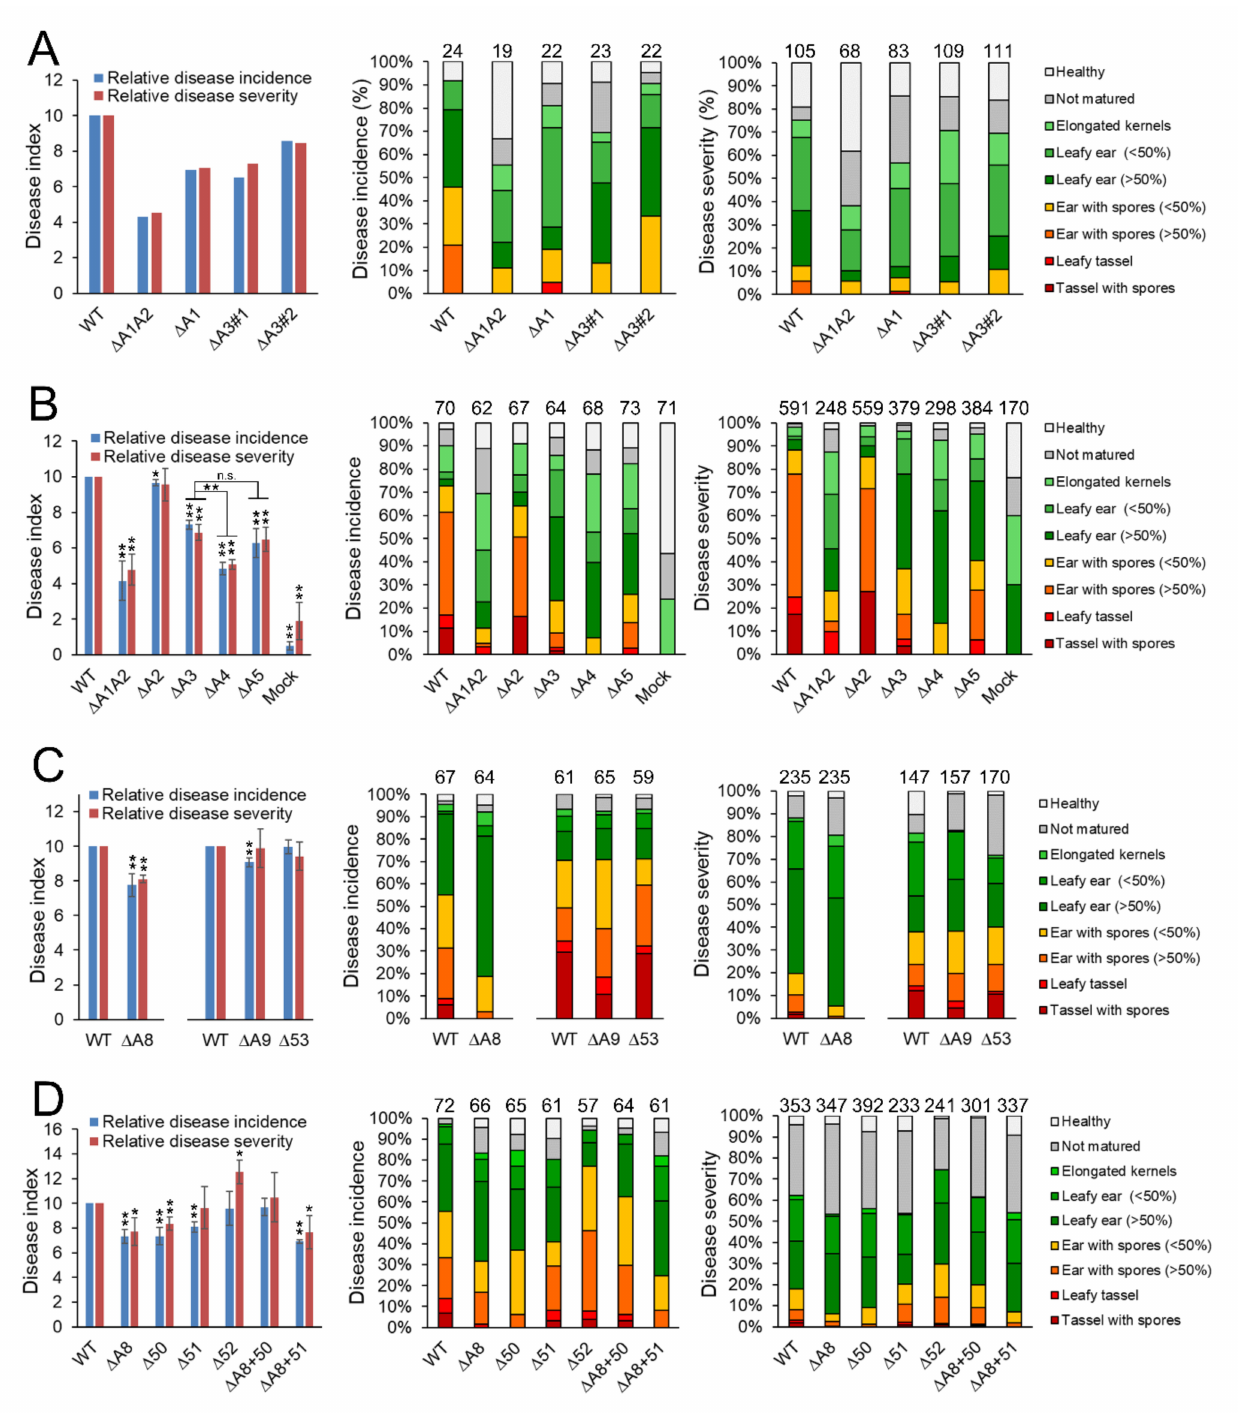
Figure 2. Dissection of virulence genes within divergence region 19-1 of S. reilianum . Virulence phenotype of subcluster gene deletion strains of S. reilianum on Zea mays cv. ‘Gaspe Flint’. Comparison of disease incidence and severity indexes ( left ), disease incidence distribution ( middle ), and disease severity distribution ( right ) are shown. Disease incidence gives the number of plants with the strongest displayed symptom (N, total number of evaluated plants), whereas disease severity gives the number of inflorescences displaying the strongest symptom (N, total number of evaluated inflorescences). N is indicated above the bar graph columns. The disease index indicates the average weighted strength of the displayed disease symptoms per total number of plants (incidence) or per total number of inflorescences (severity) relative to the respective values induced by wildtype